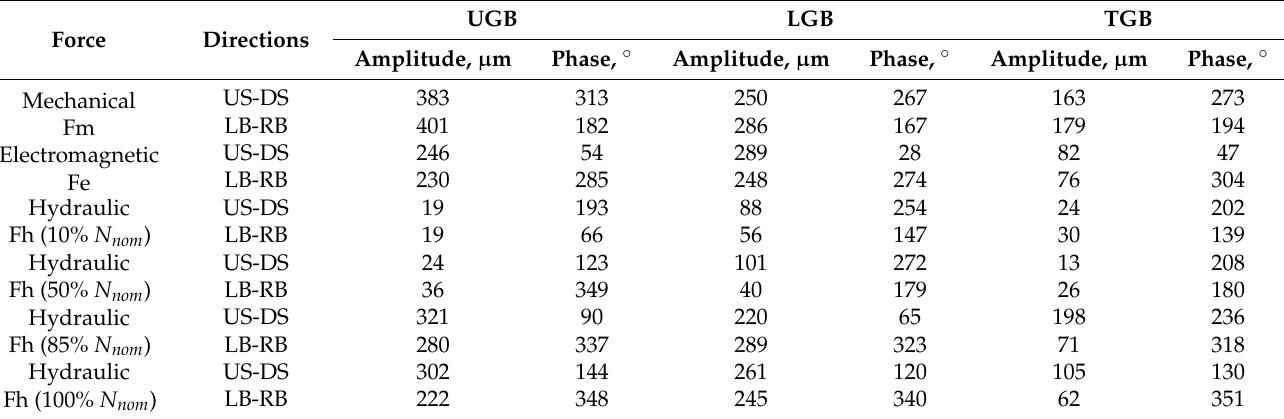
Table 3. Force increments of the 1st